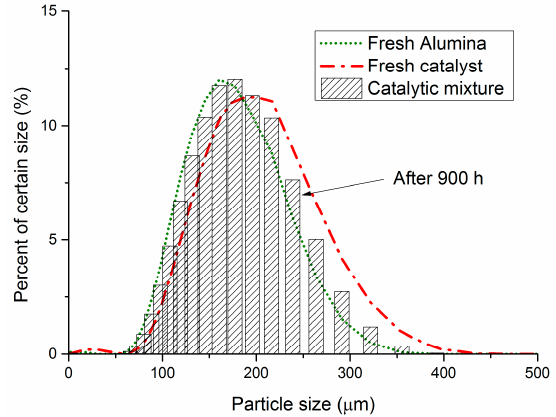
Figure 12. Particle size distribution of fresh alumina, catalyst and the catalytic batch after 900 h of continuous operation (FRITSCH ANALYSETTE 22).